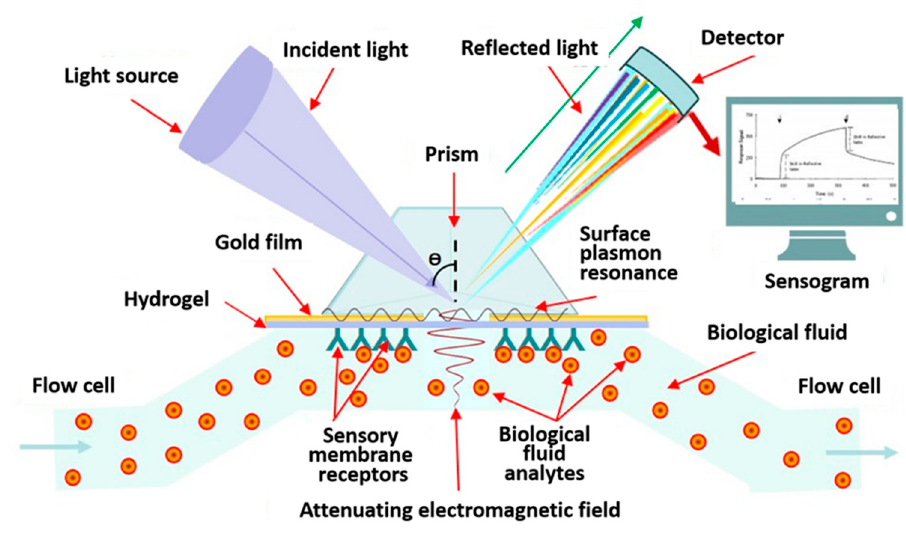
Figure 5. Advanced technologies implemented in the design of optical label-free biosensors.